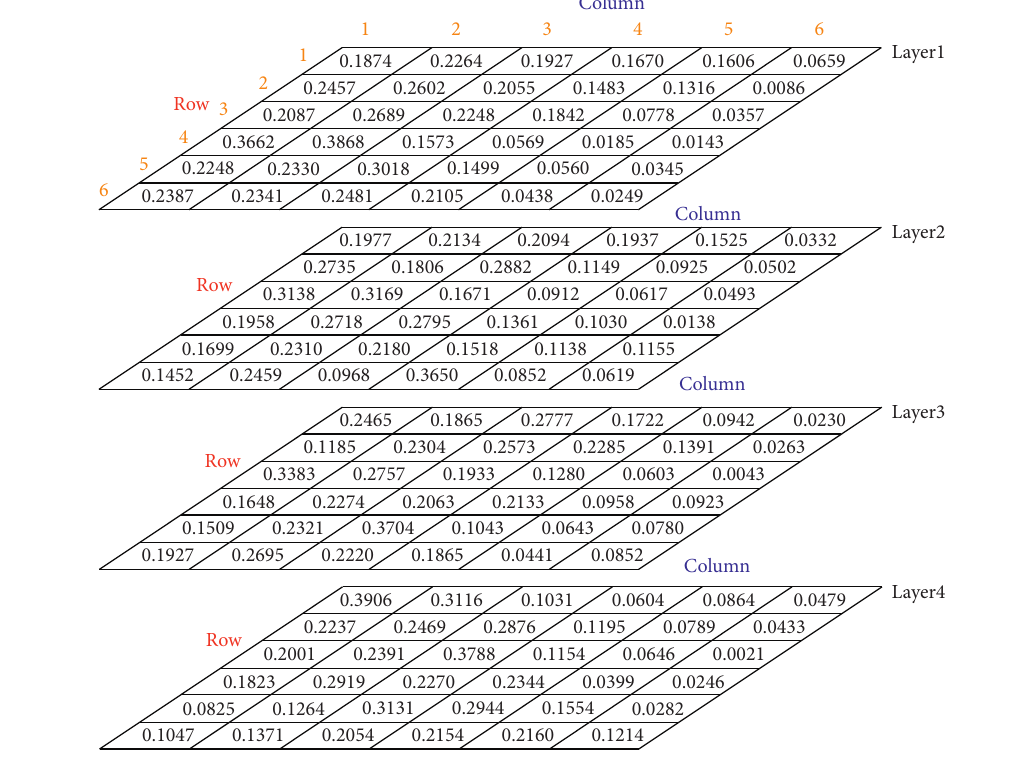
Figure 7: The optimal initial values of the observation matrix.